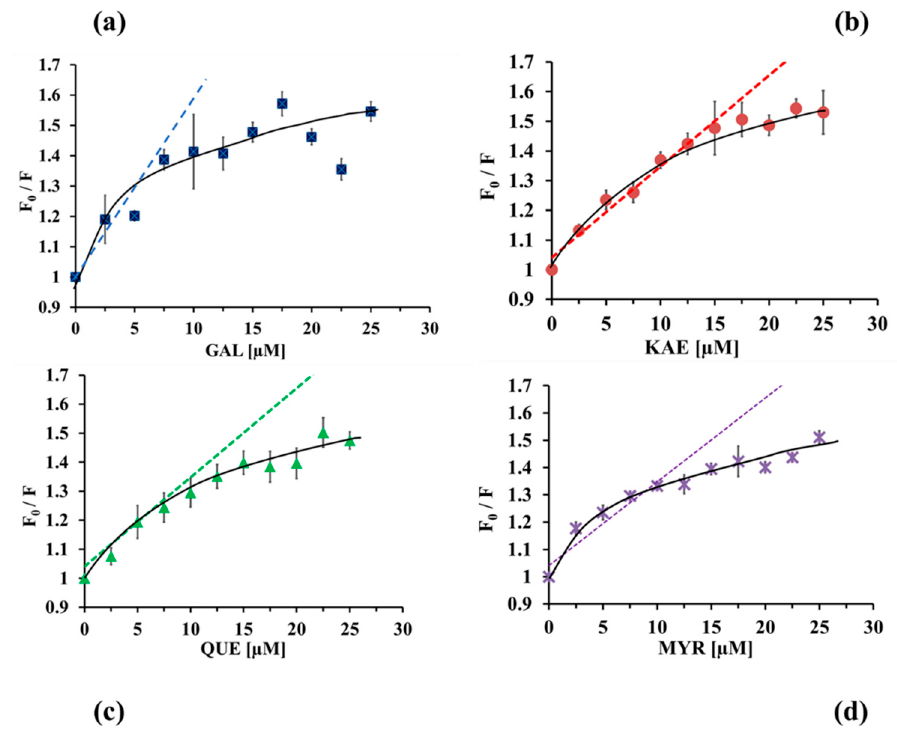
Figure 4. The Stern–Volmer plots for fluorescence quenching by ( a ) GAL (galangin), ( b ) KAE (kaempferol), ( c ) QUE (quercetin), ( d ) MYR (myricetin) at T = 298 K. CpLIP2 lipase concentration is 2.5 µM, pH 7.0. The fluorescence emission intensity was recorded at ʎ ex = 285 nm and ʎ em = 350 nm. F 0 / F versus [Q] plots exhibiting negative deviation from the linearity towards the x-axis. Bars indicate the SD with n = 9. ( a – d ) the final concentrations of flavonols correspond to the following gradient from 0, 2.5, 5.0, 7.5, 10.0, 12.5, 15.0,17.5, 20.0, 22.5 and 25 µM. The trend lines represent Stern–Volmer quenching when all W are equally accessible to flavonols. The up-down curvatures towards the x-axis represent Lehrer model taking into account the inaccessibility of some W of CpLIP2 lipase.